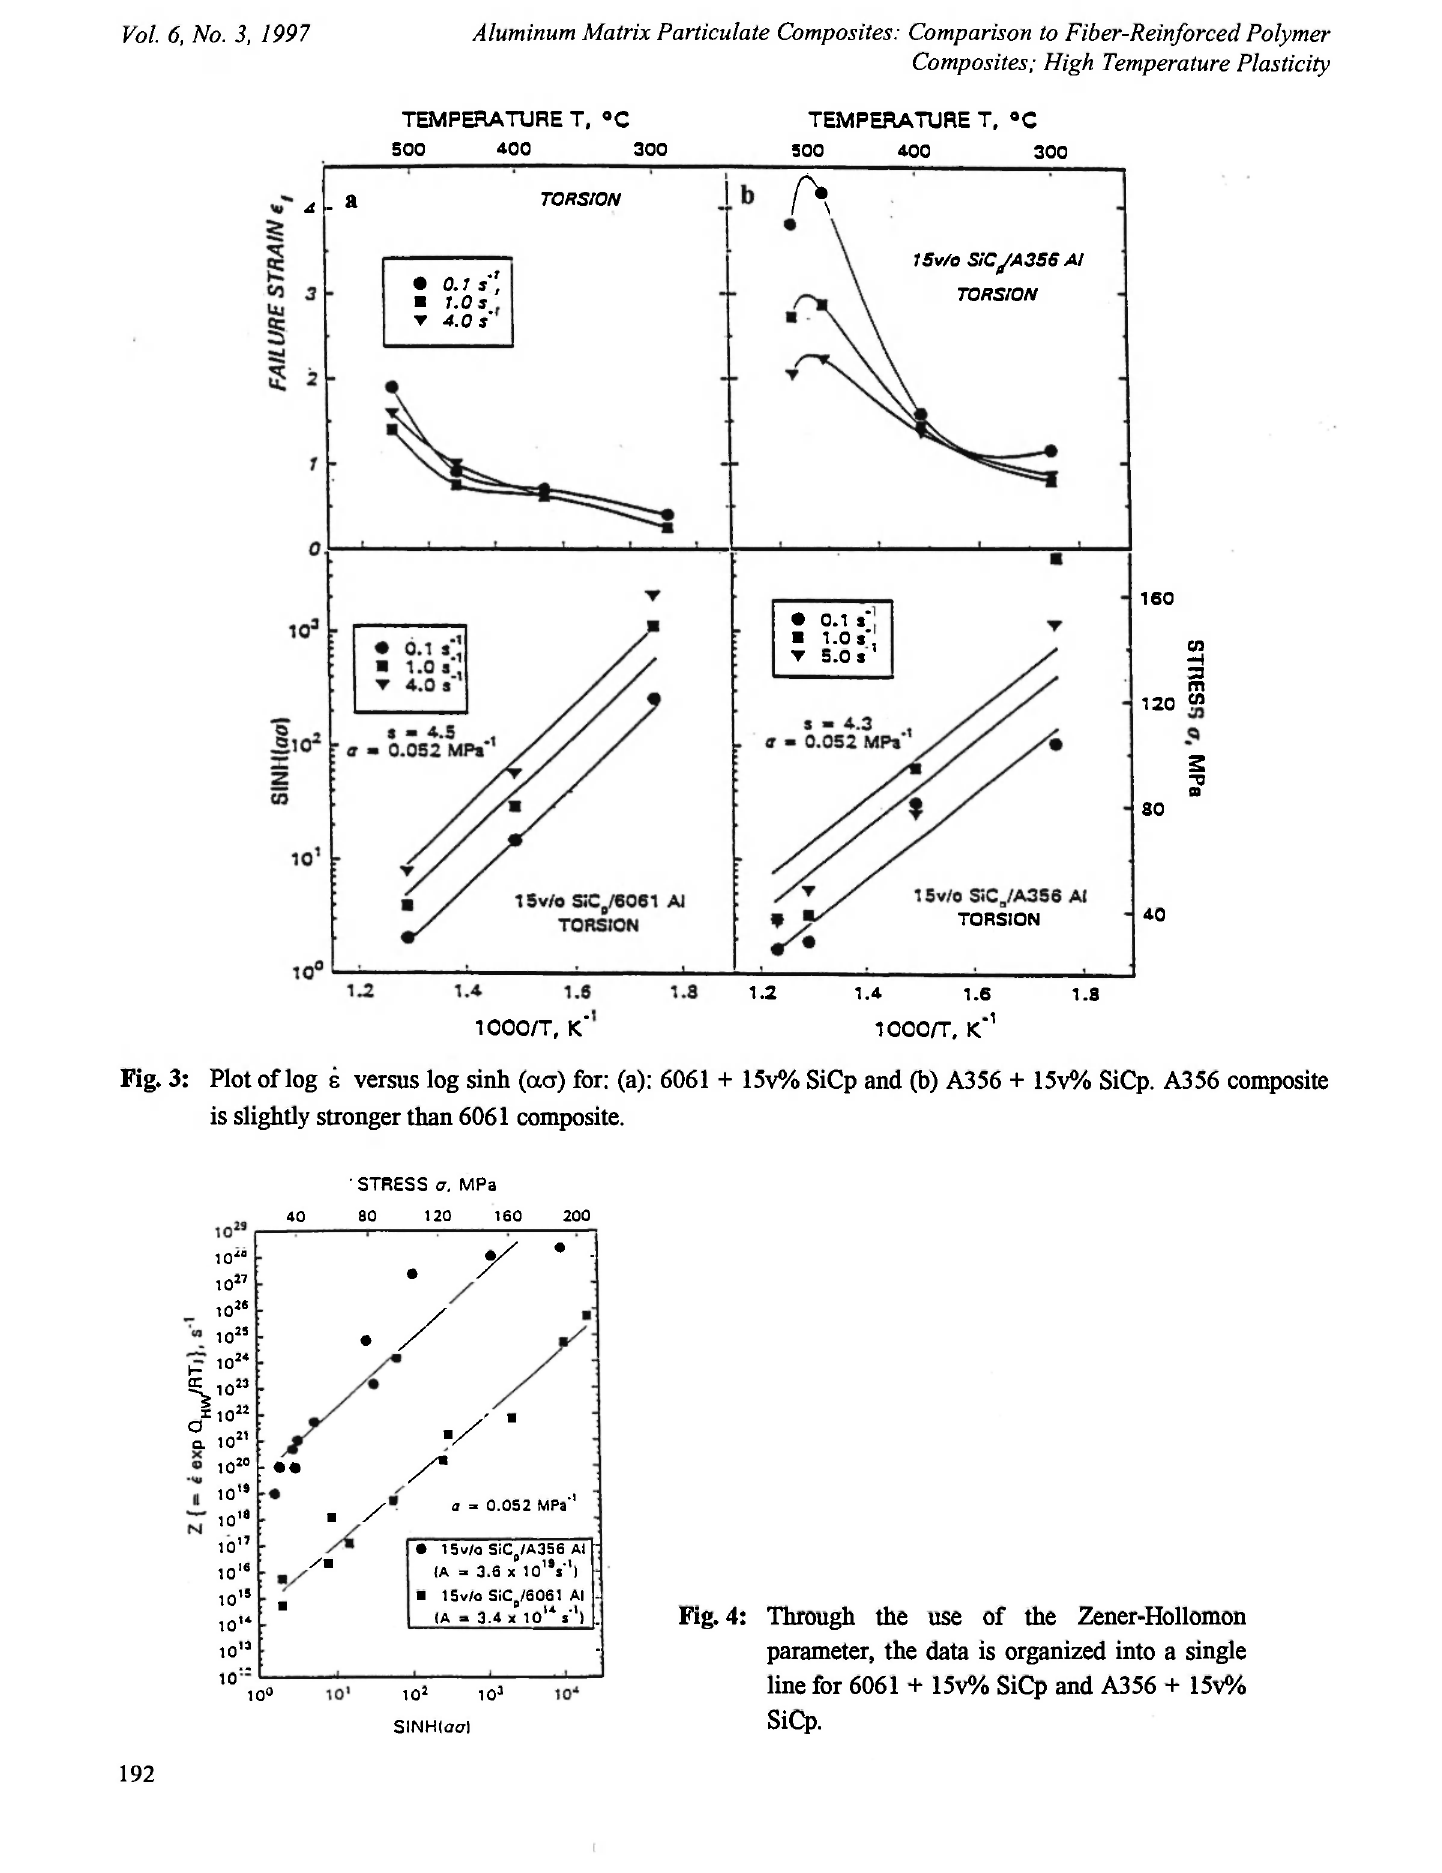
Fig. 4: Through the use of the Zener-Hollomon parameter, the data is organized into a single line for 6061 + 15v% SiCp and A356 + 15v%